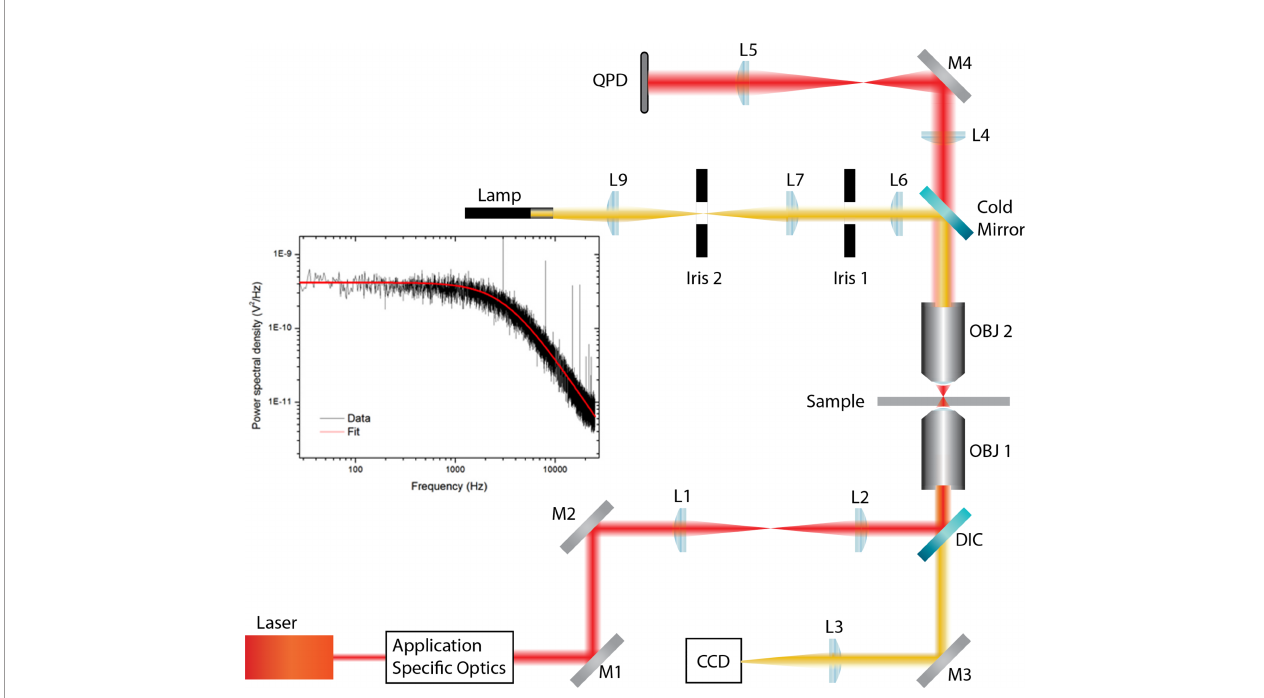
FIGURE 1 | Force measuring optical tweezer system used for static adhesion assays. OBJ 1, Nikon 1.25 NA 100x oil immersion objective; OBJ 2, Mitutoyo 0.55NA 100x long working distance objective. DIC, dichroic mirror; QPD, quadrant photodiode; L, lens; M, mirror. Application-speci fi c optics refer to expansion and beam steering optics. The sample was placed on a Thorlabs MAX302/M NanoMax piezoelectric stage, which was connected to a Thorlabs MDT630A 3-Axis piezo